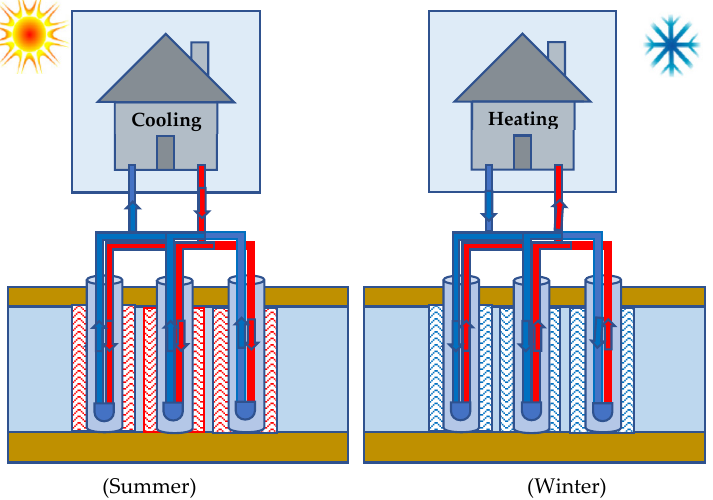
Figure 6. Schematic of Borehole Thermal Energy Storage (BTES and BHEs are connected in series).